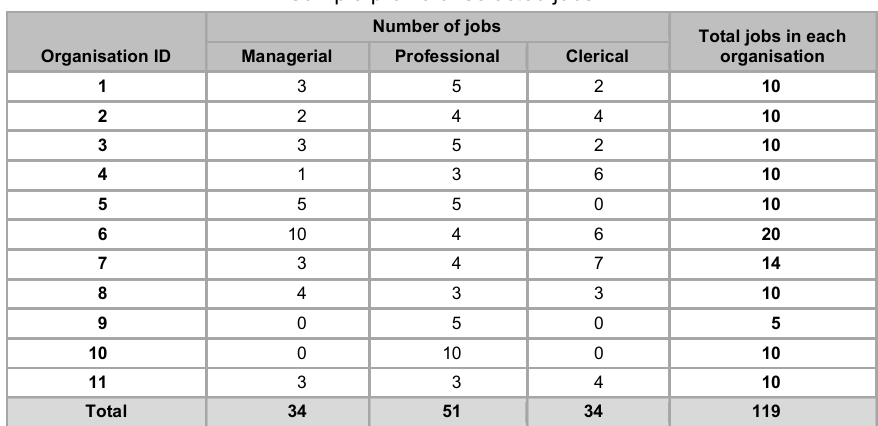
Sample profile of selected